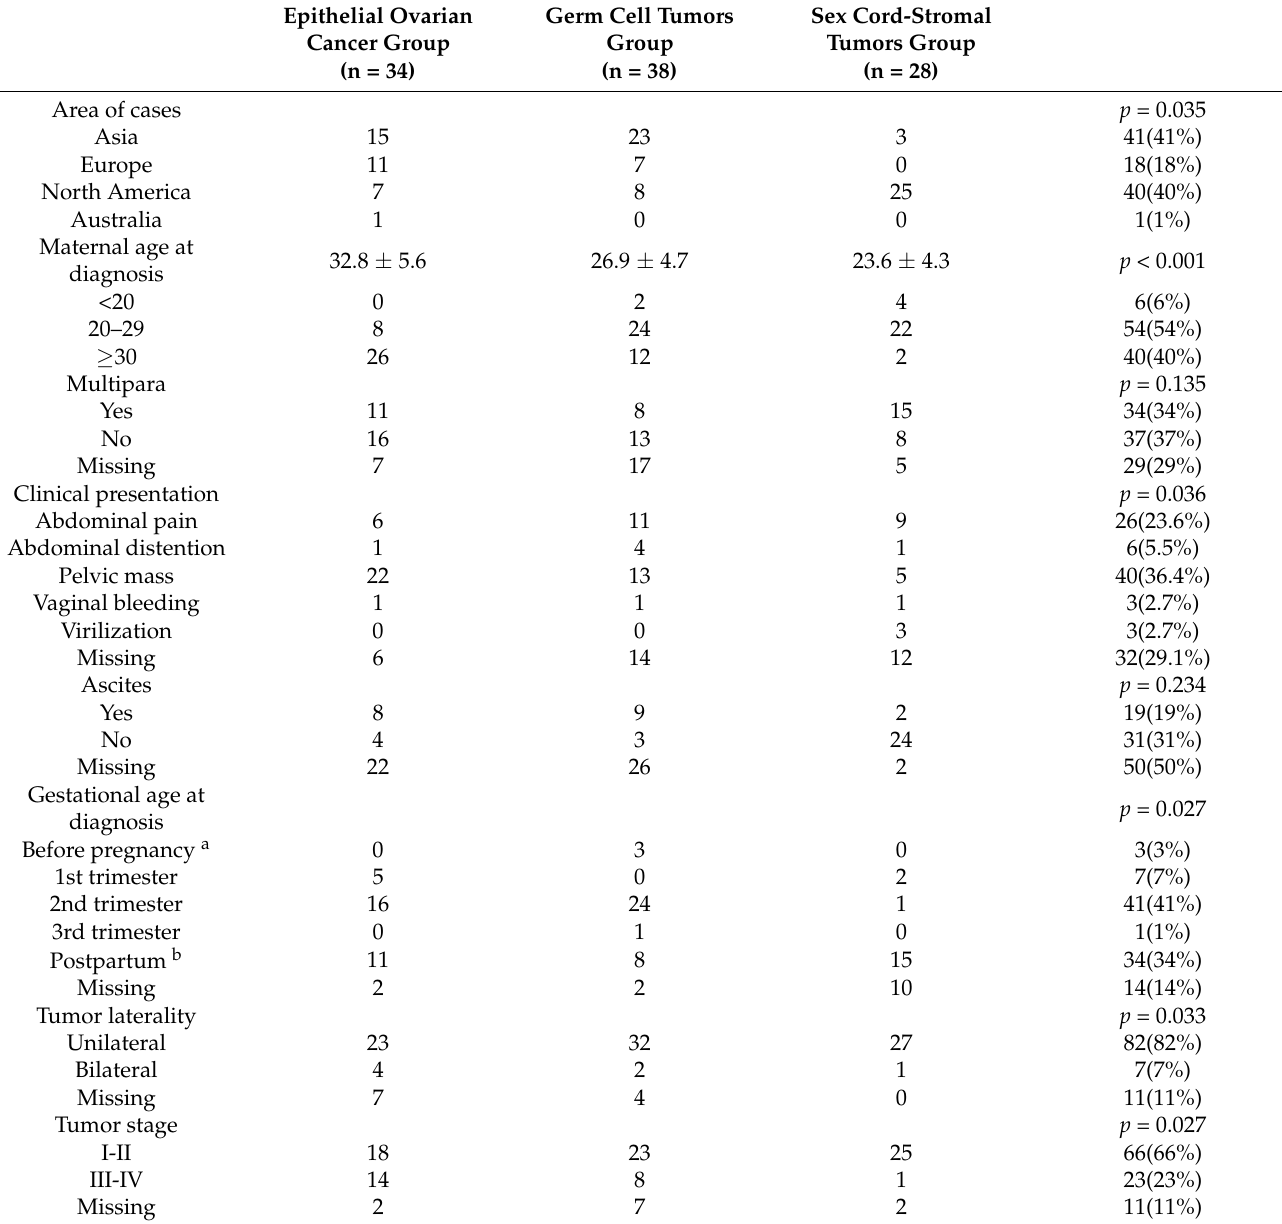
Table 1. Epidemiological characteristics of pregnant patients complicated with ovarian